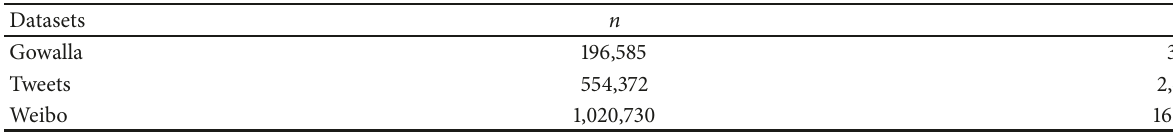
Table 1: Datasets statistic.